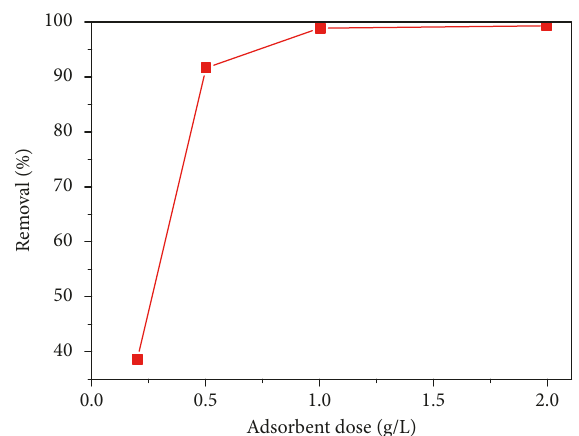
Figure 13: Effect of adsorbent dose on the methyl orange ad- sorption (contact time � 120min; C 0 � 100mg · L − 1 ; T � 20 ° C; pH ∼ 7).